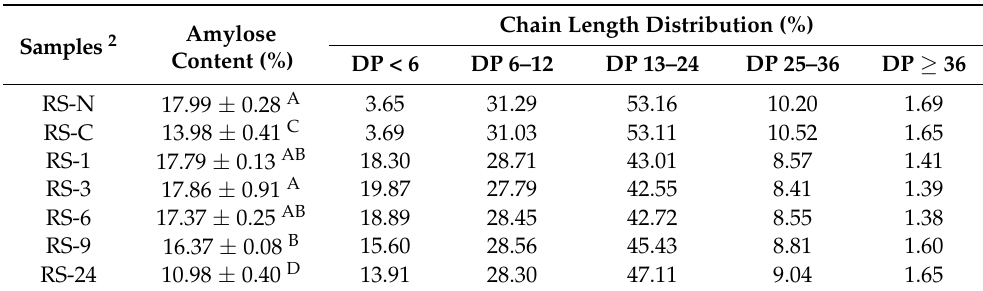
Table 4. The amylose content 1 and chain length distribution of amylopectin in native, control, and partially hydrolyzed RS.